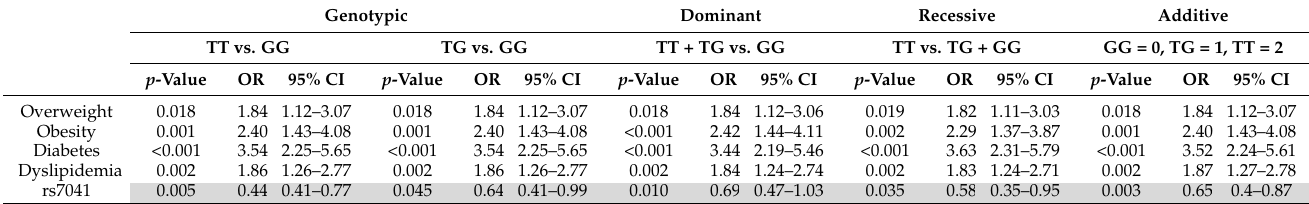
Table 3. Influence of clinical characteristics and GC rs7041 SNP on risk of HBP.